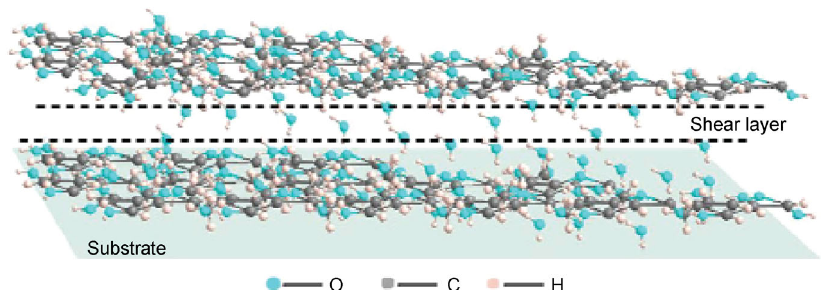
Fig. 27 Molecular structure of polysaccharide extracted from the B.S sample reported by Li et al. [137]. Copyright 2012, American Chemical Society.